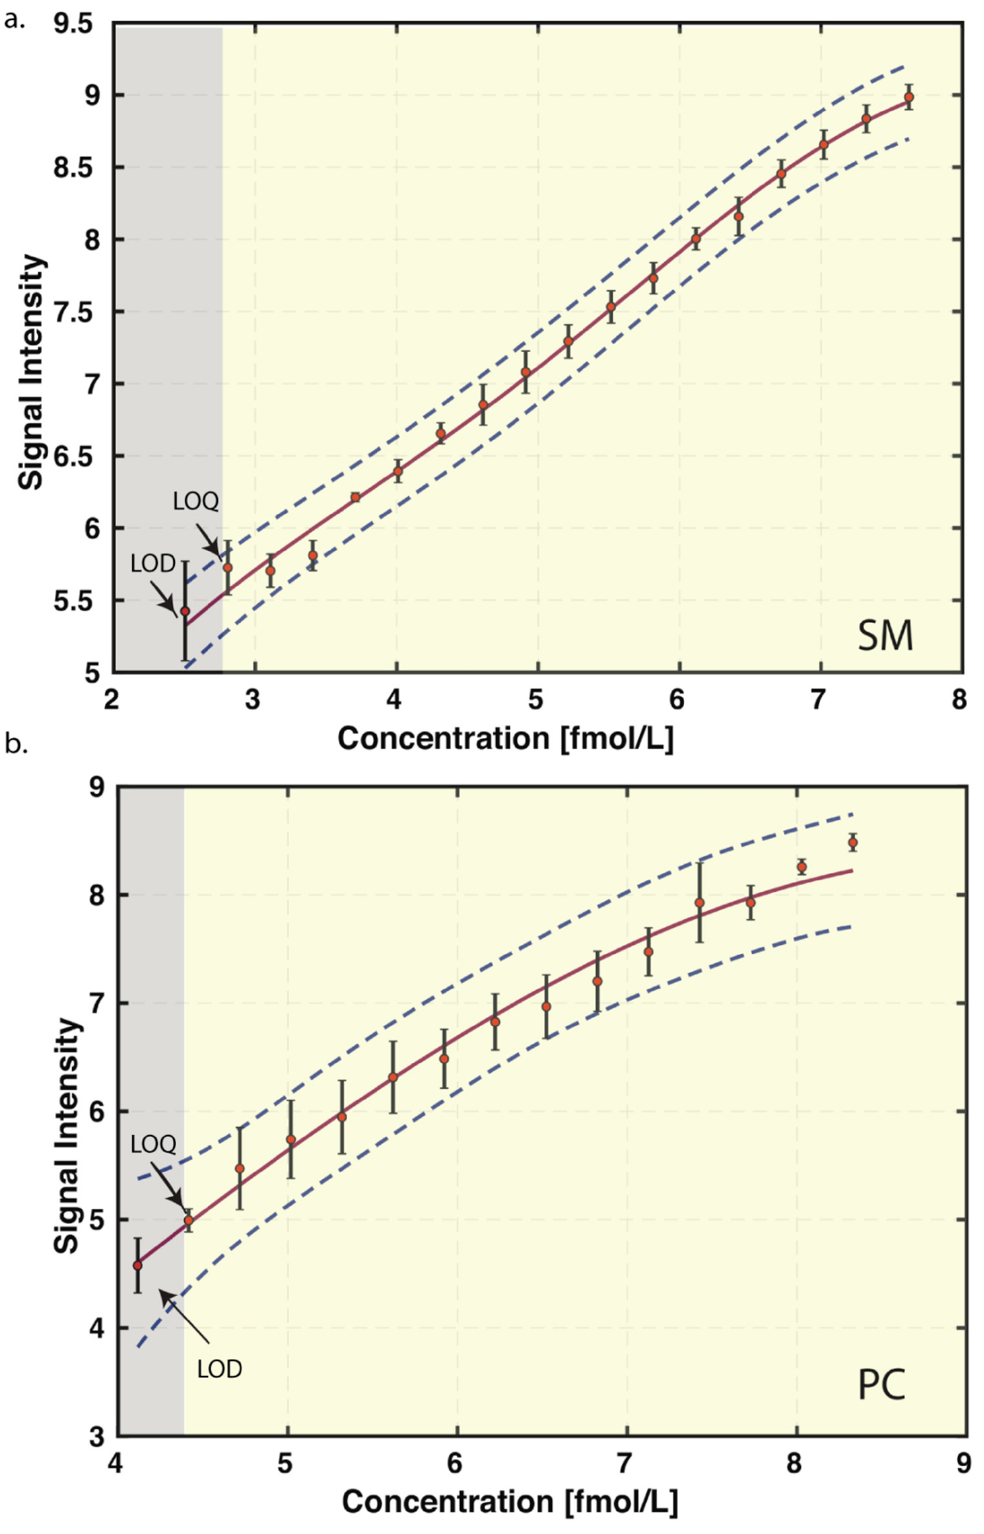
Figure 4. Representative graphs from positive and negative ion mode showing LoD, LoQ and coefficient of determination, x and y -axis was log transformed. ( a ) SM from positive ion mode and ( b ) PC from negative ion mode. The grey area represents the concentration below the linear range while the yellow region is indicative of linear range. The error bar represents the variance/standard deviation obtained in three replicates, reflecting inter day